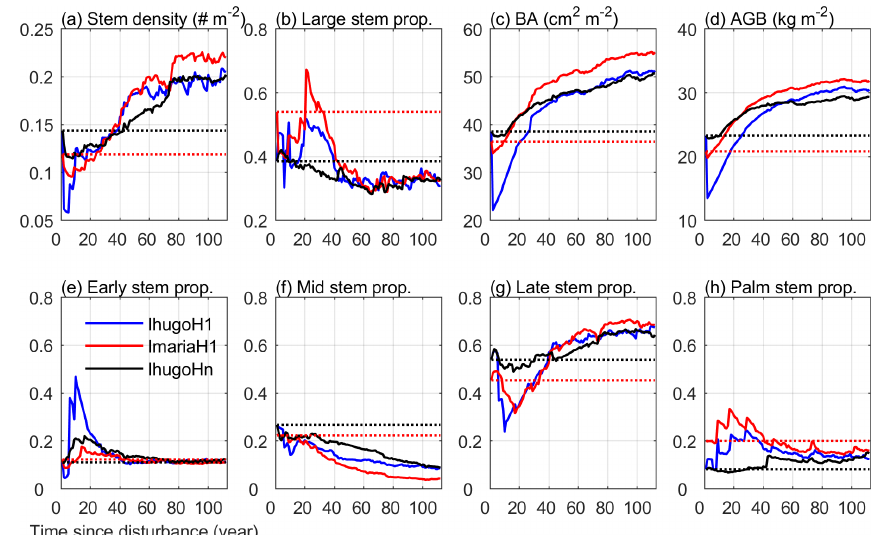
Figure 10. Time series of eight variables from the simulation of the three experiments: IhugoHn, IhugoH1, ImariaH1. The dotted lines are the initial state of the variables for each experiment (IhugoHn and IhugoH1 have the same initial state). The variables in (a) stem density, (c) basal area, and (d) aboveground biomass are for stems with DBH ≥ 2 . 5cm. The stem proportion in (b) is the proportion of the stem density with DBH ≥ 10cm to the stem density with DBH ≥ 2 . 5cm. The variables in (e) – (h) are the proportion of the stem density of each PFT with DBH ≥ 2 . 5cm to the total stem density of all PFTs with DBH ≥ 2 . 5cm.